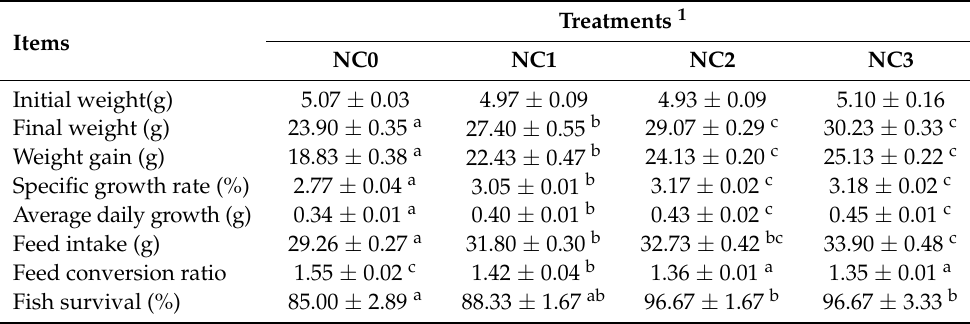
Table 2. Growth parameters and survival rate of Red Tilapia ( Oreochromis sp.) after 56 day- feeding trials.